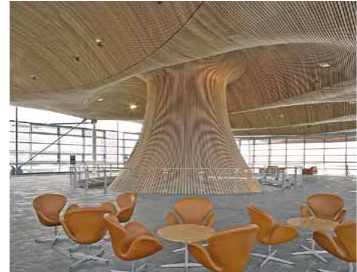
21 pav. Šachmatų klubo Chanty Mansijske eksterjeras, Rusija, archit. E. van Egeraat, 2010 m. Fig. 21. Chess club, exterior view, Chanty Mansijsk, Russia, archit. E. van Egeraat, 2010